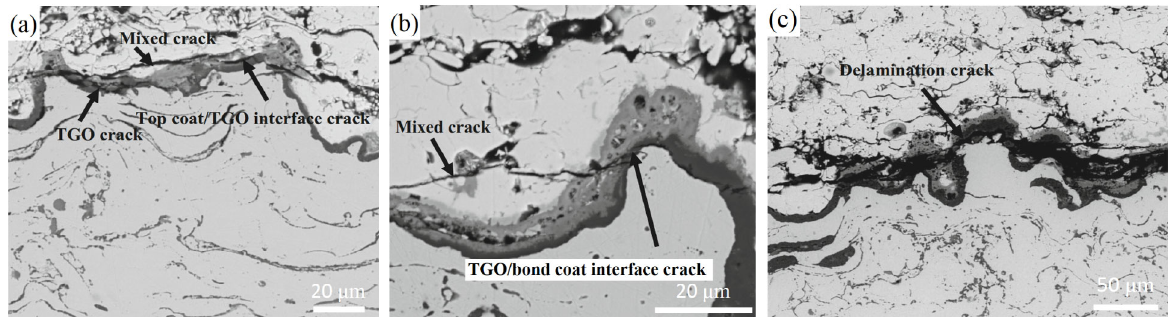
Fig. 40 SEM examination of cracks in the APS TBC specimen aged at 1050 ℃ for (a) 200 h, (b) 900 h, and (c) 1970 h. Reproduced with permission from Ref. [36], © ASM International